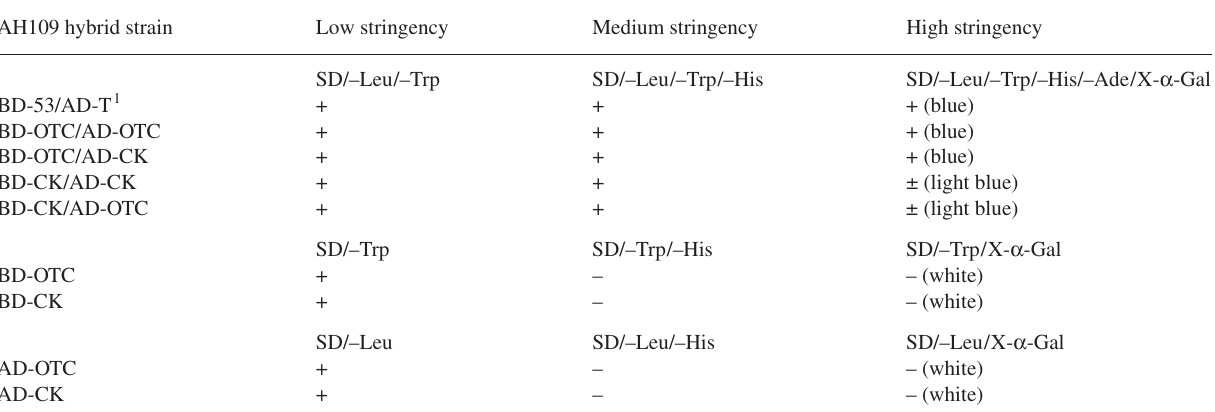
Table 1. Yeast two-hybrid analysis. Growth of the two-hybrid strainon selectionmedia:+ = growth; and – = no growth. Abbreviations:BD = bind- ing domain; AD = activation domain; OTC = ornithine carbamoyltransferase; and CK = carbamate kinase. AH109 hybrid